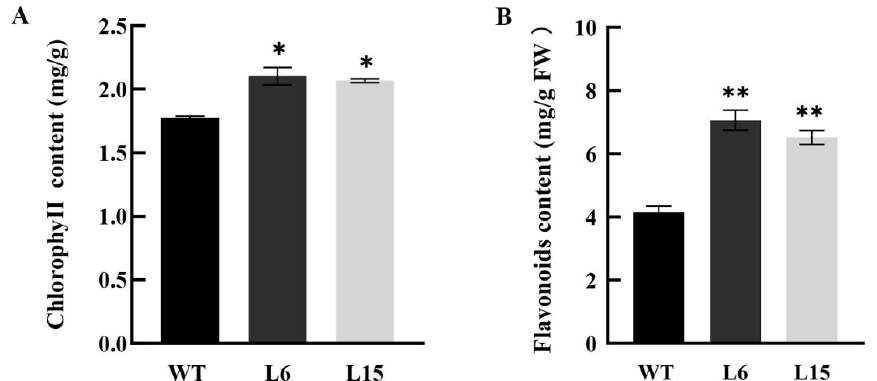
Figure 7. The chlorophyll and flavonoid content of leaves in CpSRG1 transgenic and wild-type Arabidopsis . ( A ) chlorophyll content. ( B ) flavonoid content. WT (wild-type plants, Col-0); L6 & L5, transgenic plants overexpressed CpSRG1 . Data represent mean of three biological repeats ± SEM. Error bars indicate the standard error of mean. Asterisks denote statistically significant differences compared with control, * p < 0.05, ** p < 0.01.